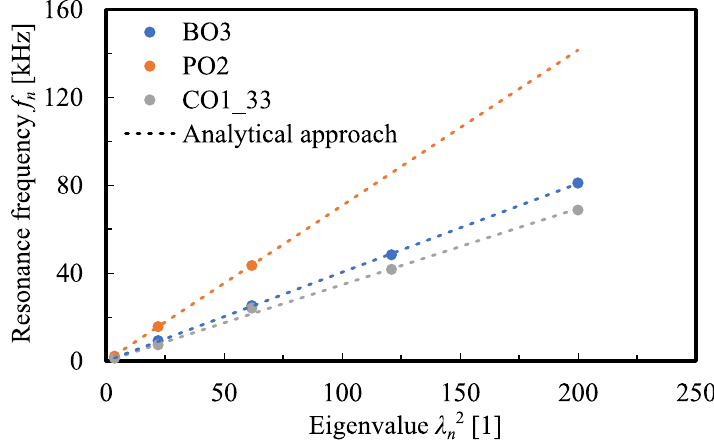
Figure 5. Exemplary resonance frequency plot of three oscillator geometries dependent on the eigenvalue. Additionally, the analytical calculation according to Equation (3) is included, which shows a very good agreement. Mode 4 and 5 of micro-oscillator PO2 were electrically not measurable with the piezoelectric elements because the deflection is not in the area of the sensing patches. Table 1. Listing of all investigated MEMS oscillator geometries and their dimensions. The thickness T is obtained from numerical simulations and the scale factor α is determined by applying best fit method of Equation (3) to resonance frequency plot shown in Figure 5. The Young’s modulus E Si = 130 GPa and density ρ S i = 2.330 g/cm 3 are taken from [29].